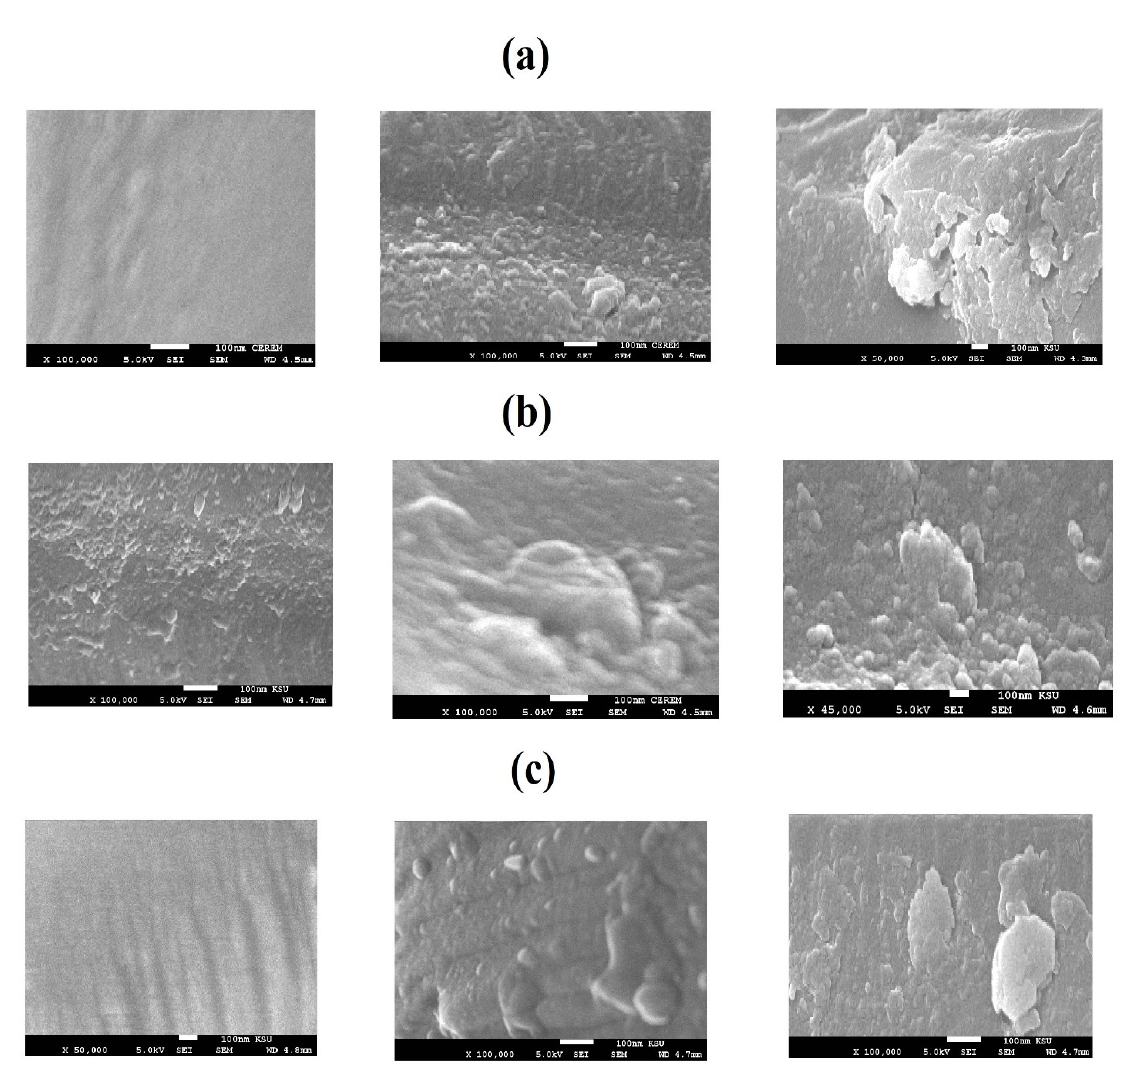
Figure 11. SEM micrographs of fractured cured DGEB/PA films using different wt % from left to right 1, 3 and 10 wt % of Ag NPs capped ( a ) EOA, ( b ) ELOA and ( c ) ELNA.